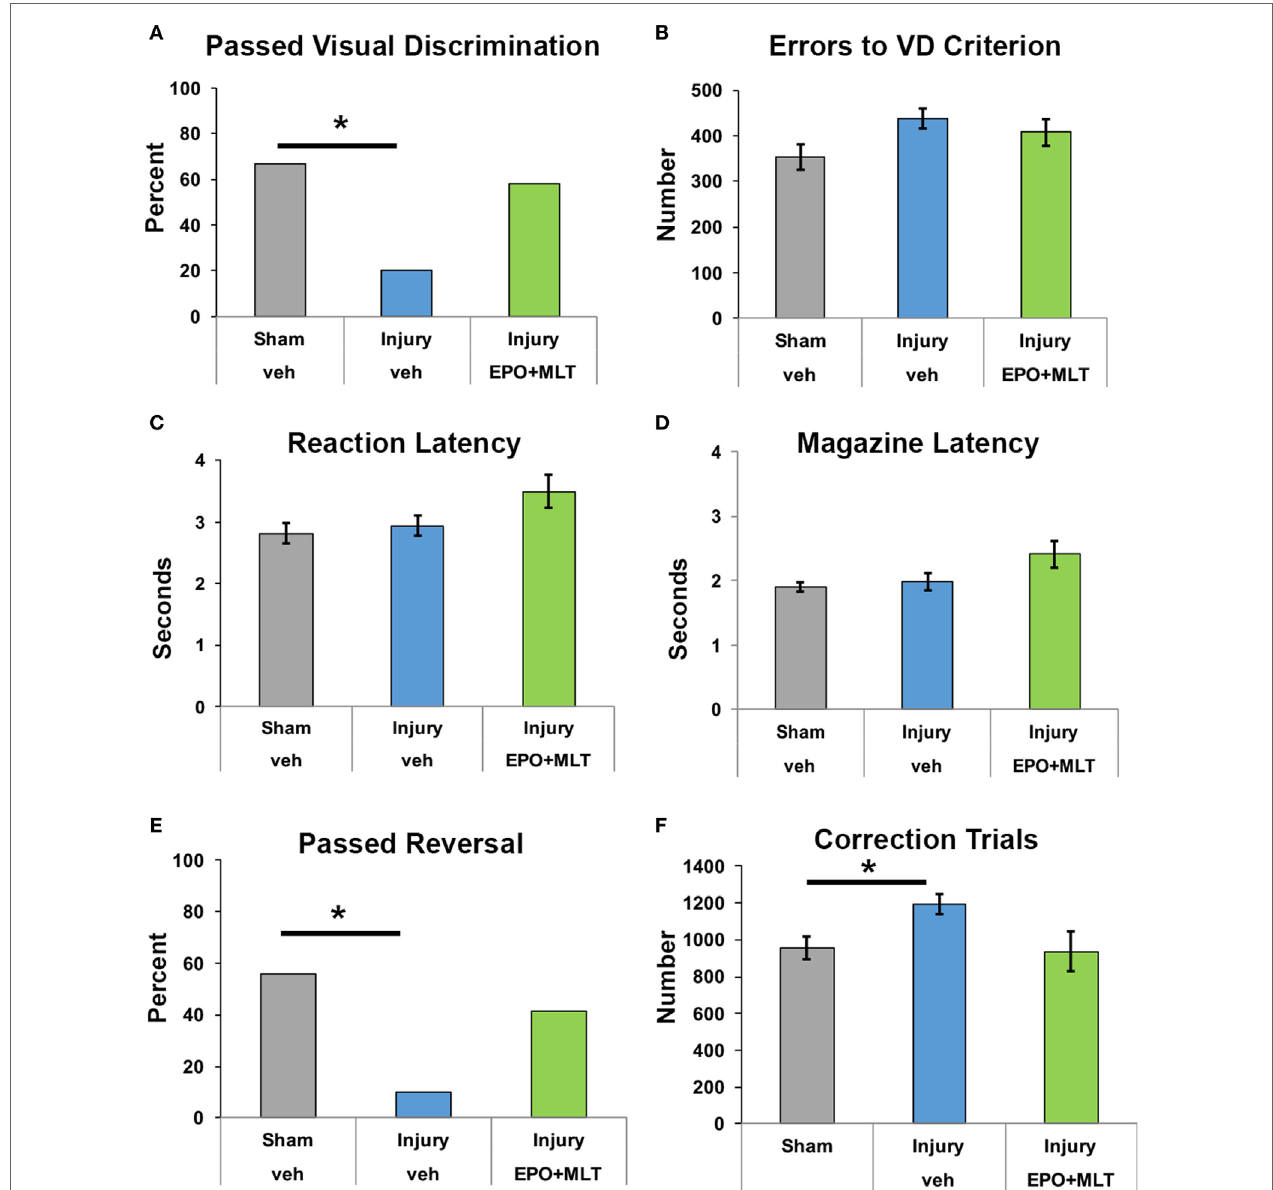
FigUre 4 | Touchscreen operant chamber testing reveals impaired cognition. (a) Fewer vehicle-treated rats after prenatal injury successfully reached passing criterion for visual discrimination, compared to shams or erythropoietin (EPO) + melatonin (MLT)-treated injured rats (* p < 0.05). (B) Shams, vehicle-treated rats with prenatal injury, and EPO + MLT-treated rats with prenatal injury all committed approximately the same number of errors during visual discrimination testing. (c) The reaction latency between the three groups did not differ. (D) Likewise, the magazine latency was similar for all three groups. (e) Significantly fewer vehicle-treated rats after prenatal injury were able to pass criterion for VD and reversal (* p < 0.05). (F) After prenatal injury, vehicle-treated rats required more correction trials in reversal learning paradigms than